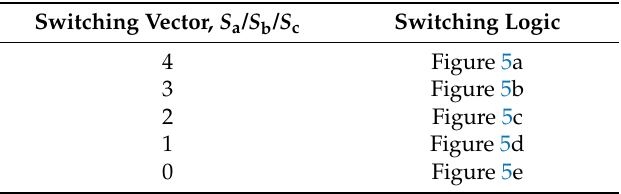
Table A2. Switching logic for different switching vector.